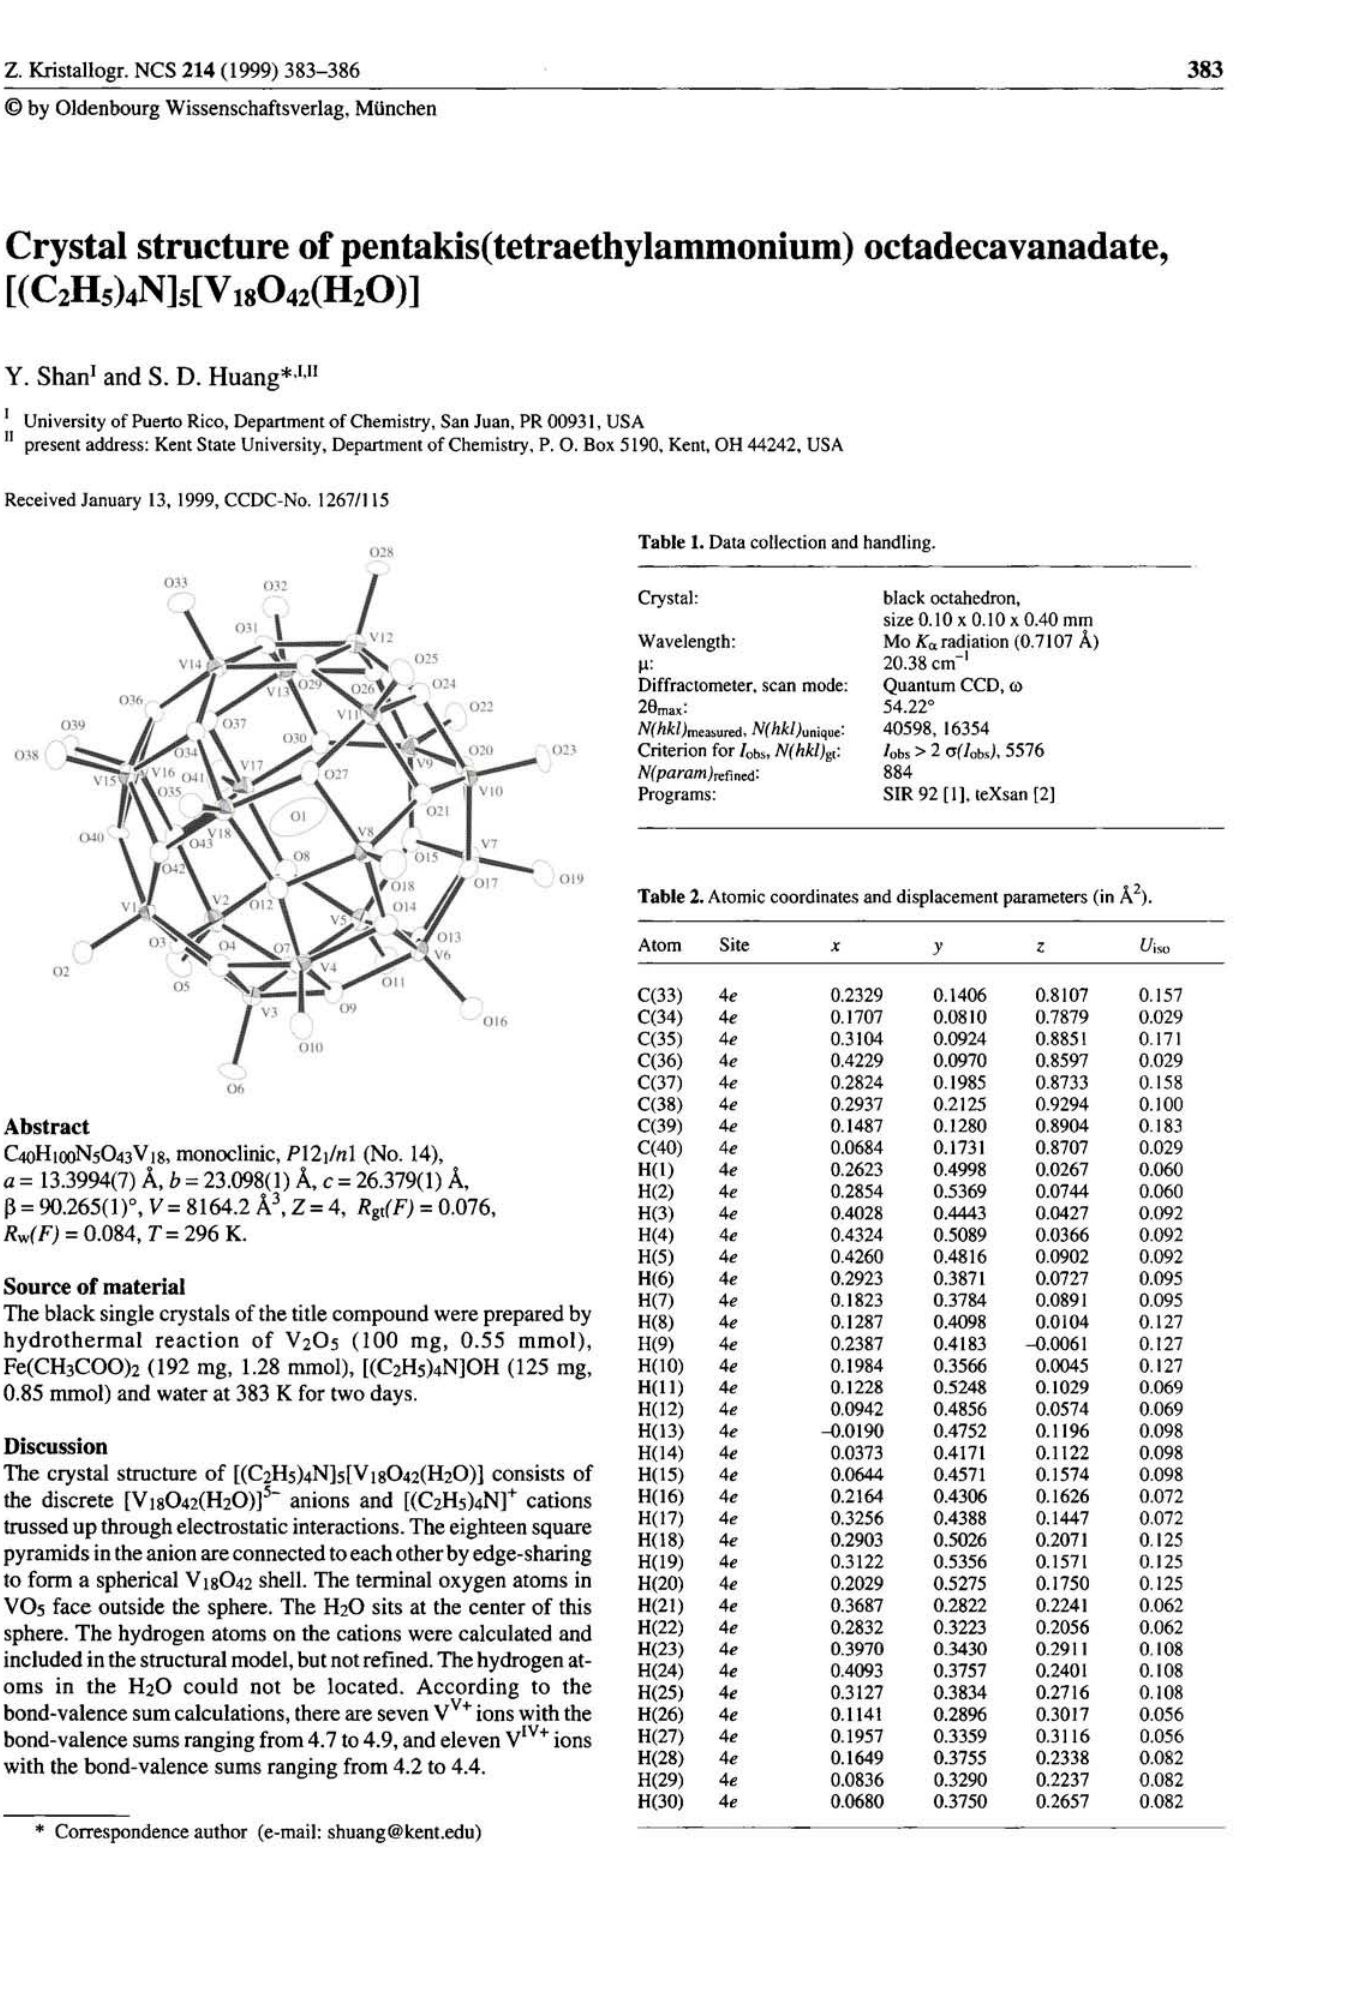
Table 1. Data collection and handling.